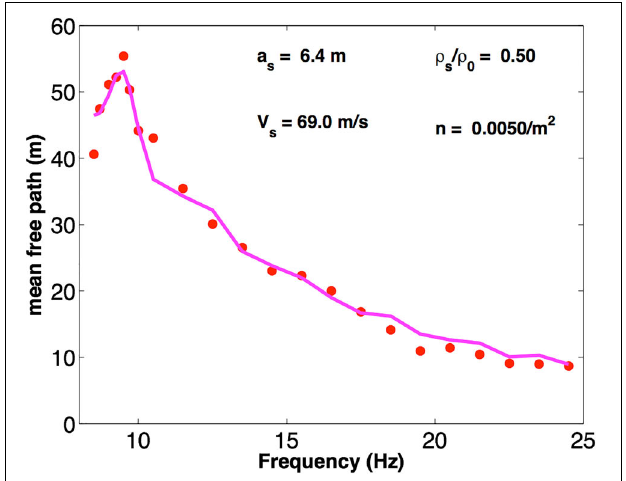
FIGURE 6 | The best-fit solution for the mean free path using the penetrable single scatterer model. The figure shows the fit between the experimental l s (red dots) and the one predicted by the model as a function of the frequency; the scatterer properties are reported within the panel.